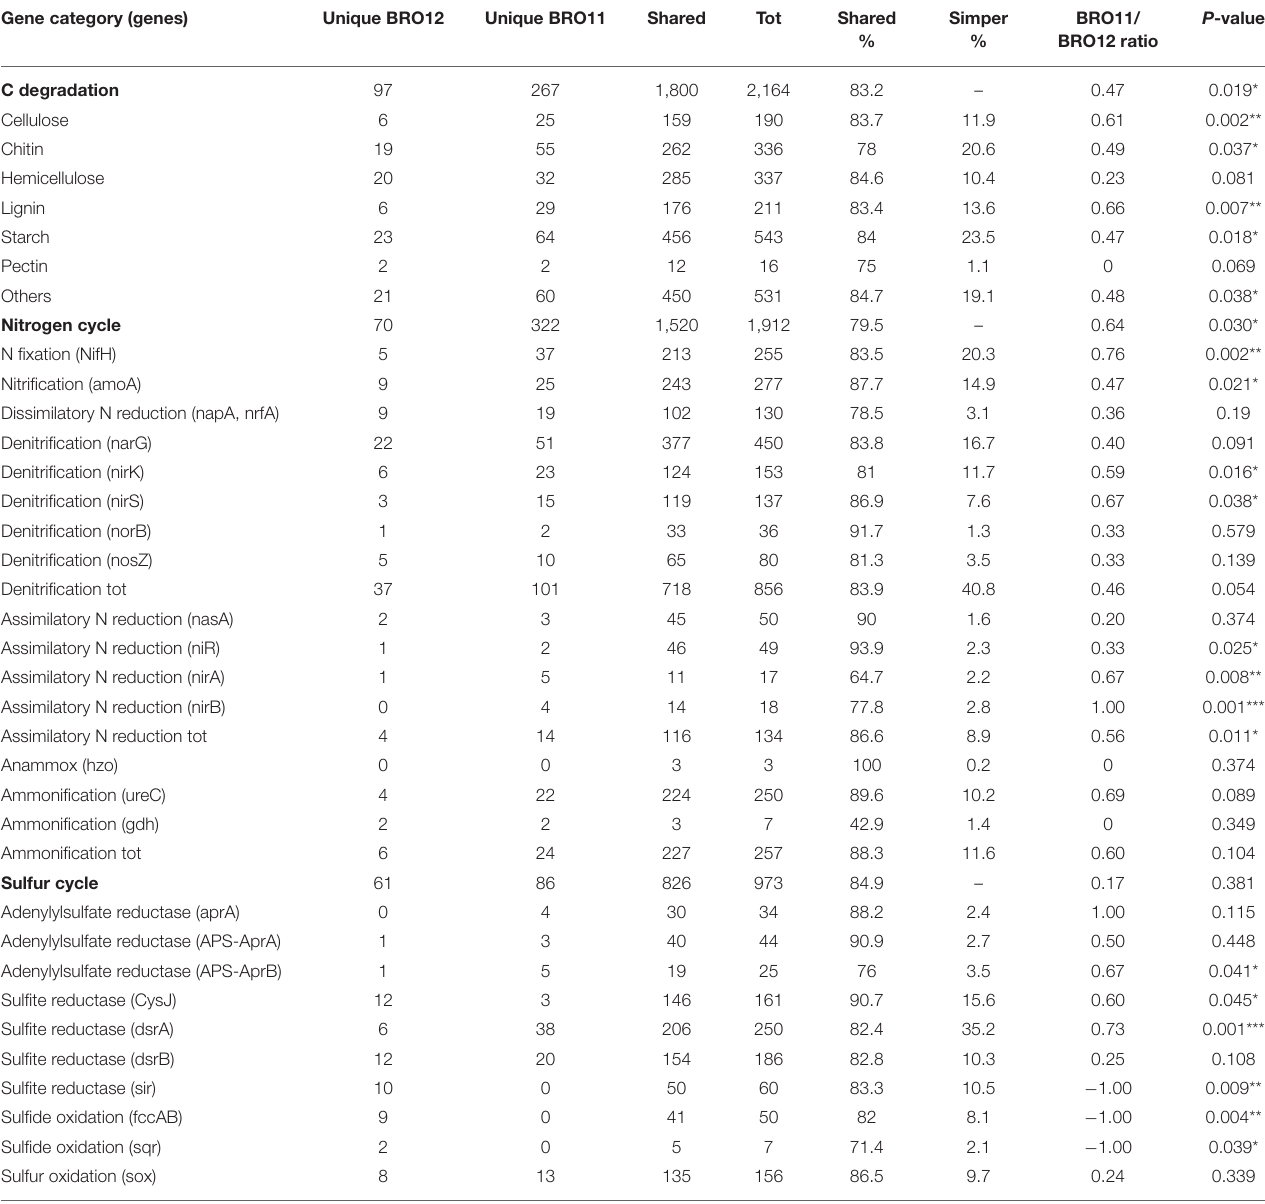
TABLE 3 | The detected gene probes involved in carbon, nitrogen, and sulfur cycling and their main sub-categories. Gene category (genes) Unique BRO12 Unique BRO11 Shared